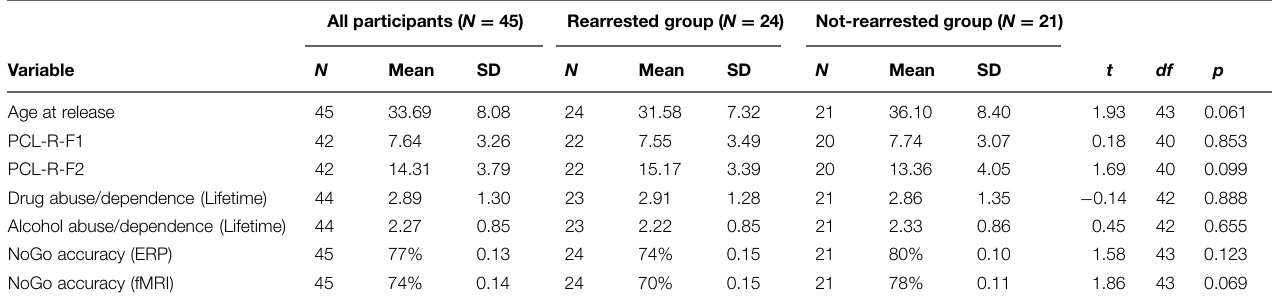
TABLE 1 | Descriptive statistics and independent samples t -tests for variables used as covariates. All participants ( N = 45) Rearrested group ( N = 24) Not-rearrested group ( N =